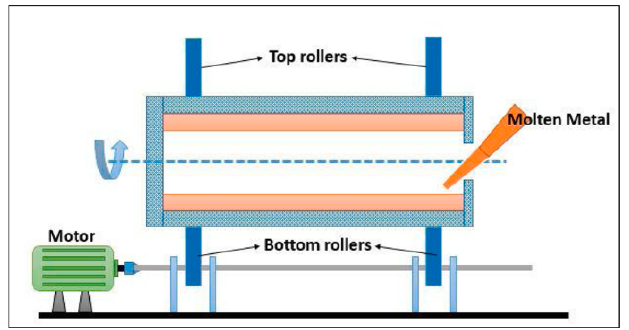
Figure 10. Centrifugal casting process [68].